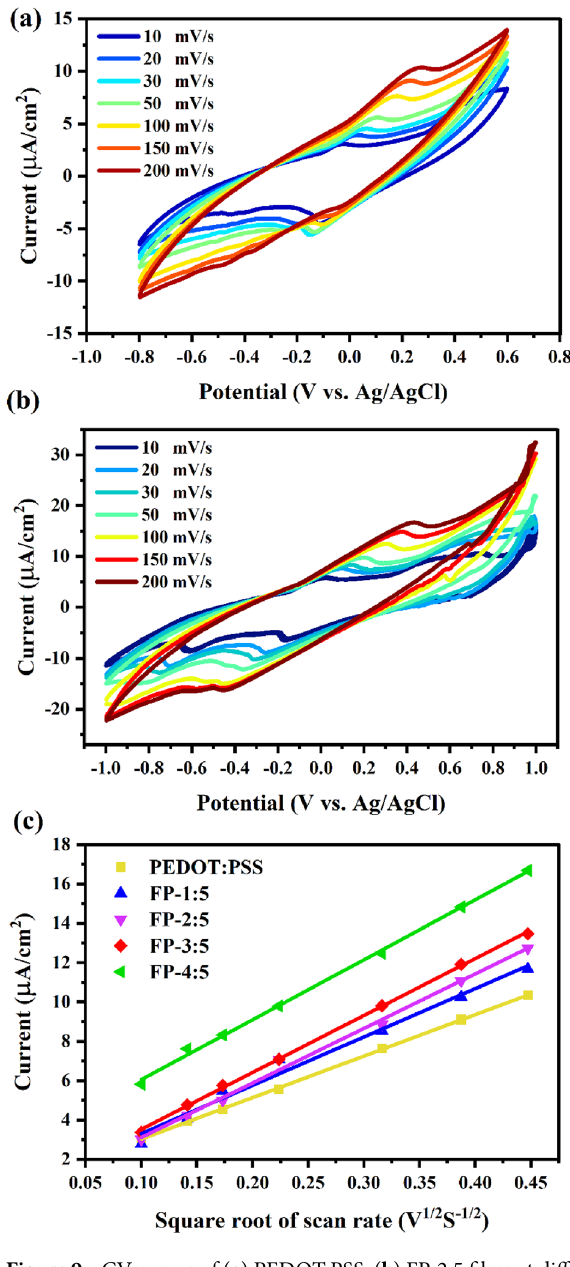
Figure 9. CV curves of ( a ) PEDOT:PSS, ( b ) FP-2:5 films at different scanning rates in a mixture solution of 10 mM K 3 (FeCN) 6 and 0.1 M KCl and ( c ) plots of the oxidation current of [Fe(CN) 6 ] 3−/4− ( Ip ) versus v 1/2 with their corresponding